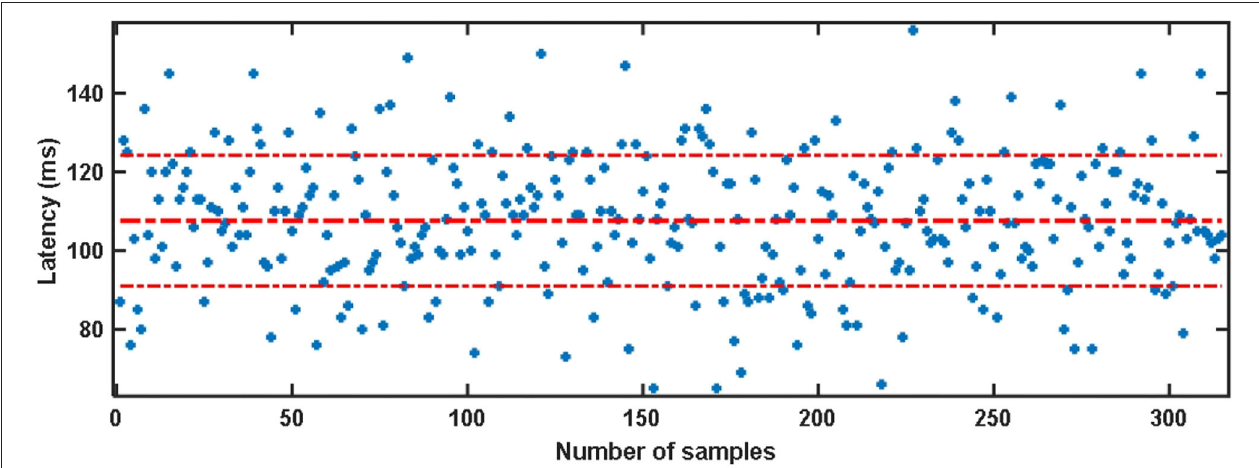
FIGURE 3 | Artificial estimation of the visual latency and its average value in the SSMVEP